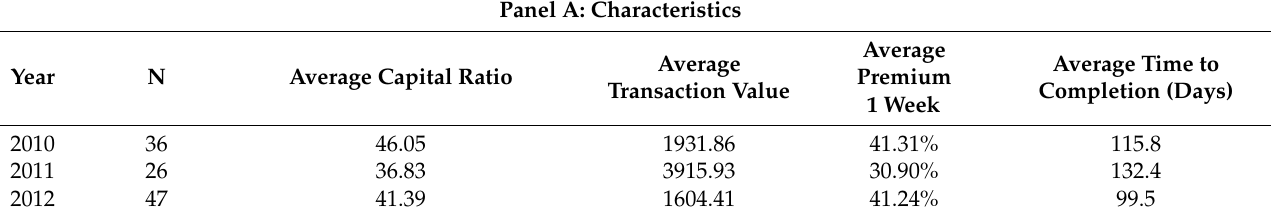
Table 2. Non-Banks: Characteristics, Returns, and Performance. The three panels of this table show the time series (year by year) of transaction and acquirer characteristics as at the time of M&A an- nouncements, announcement period abnormal returns, and post issue abnormal returns and post issue performance, for non-banks. Other summary statistics include median, standard deviation, and skewness; and, they are reported for the overall sample immediately below the year-by-year averages. Panel A: